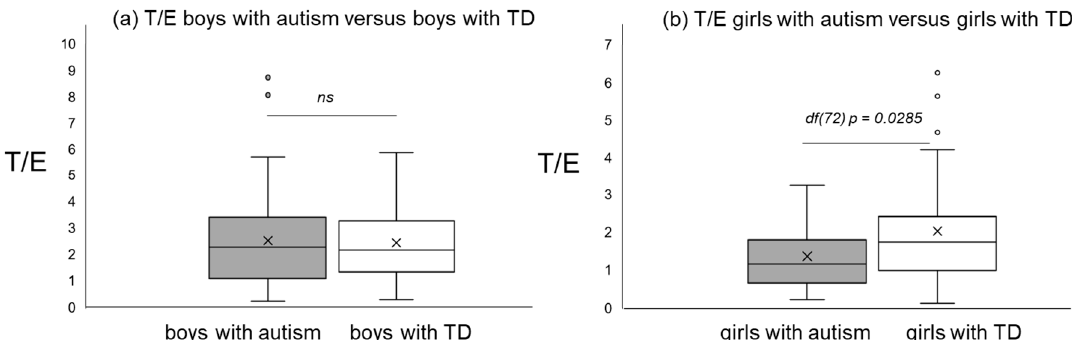
Figure 1. T/E ratios of boys with autism versus typical development ( a ) and T/E ratios of girls with autism versus typical development ( b ).